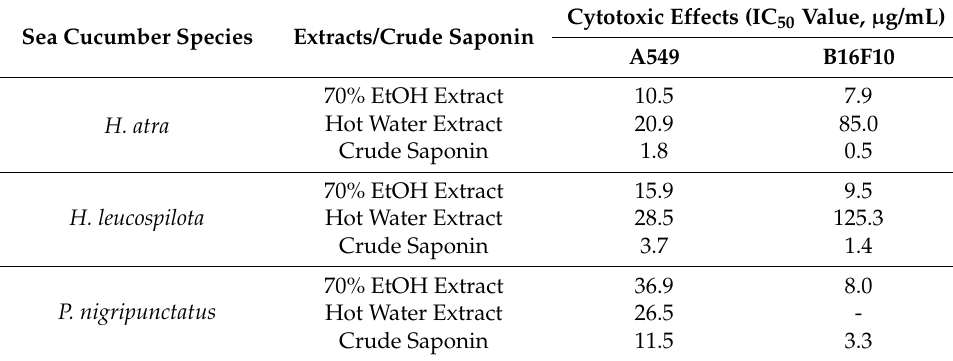
Table 1. Cytotoxic effects of different sea cucumber extracts/crude saponin.